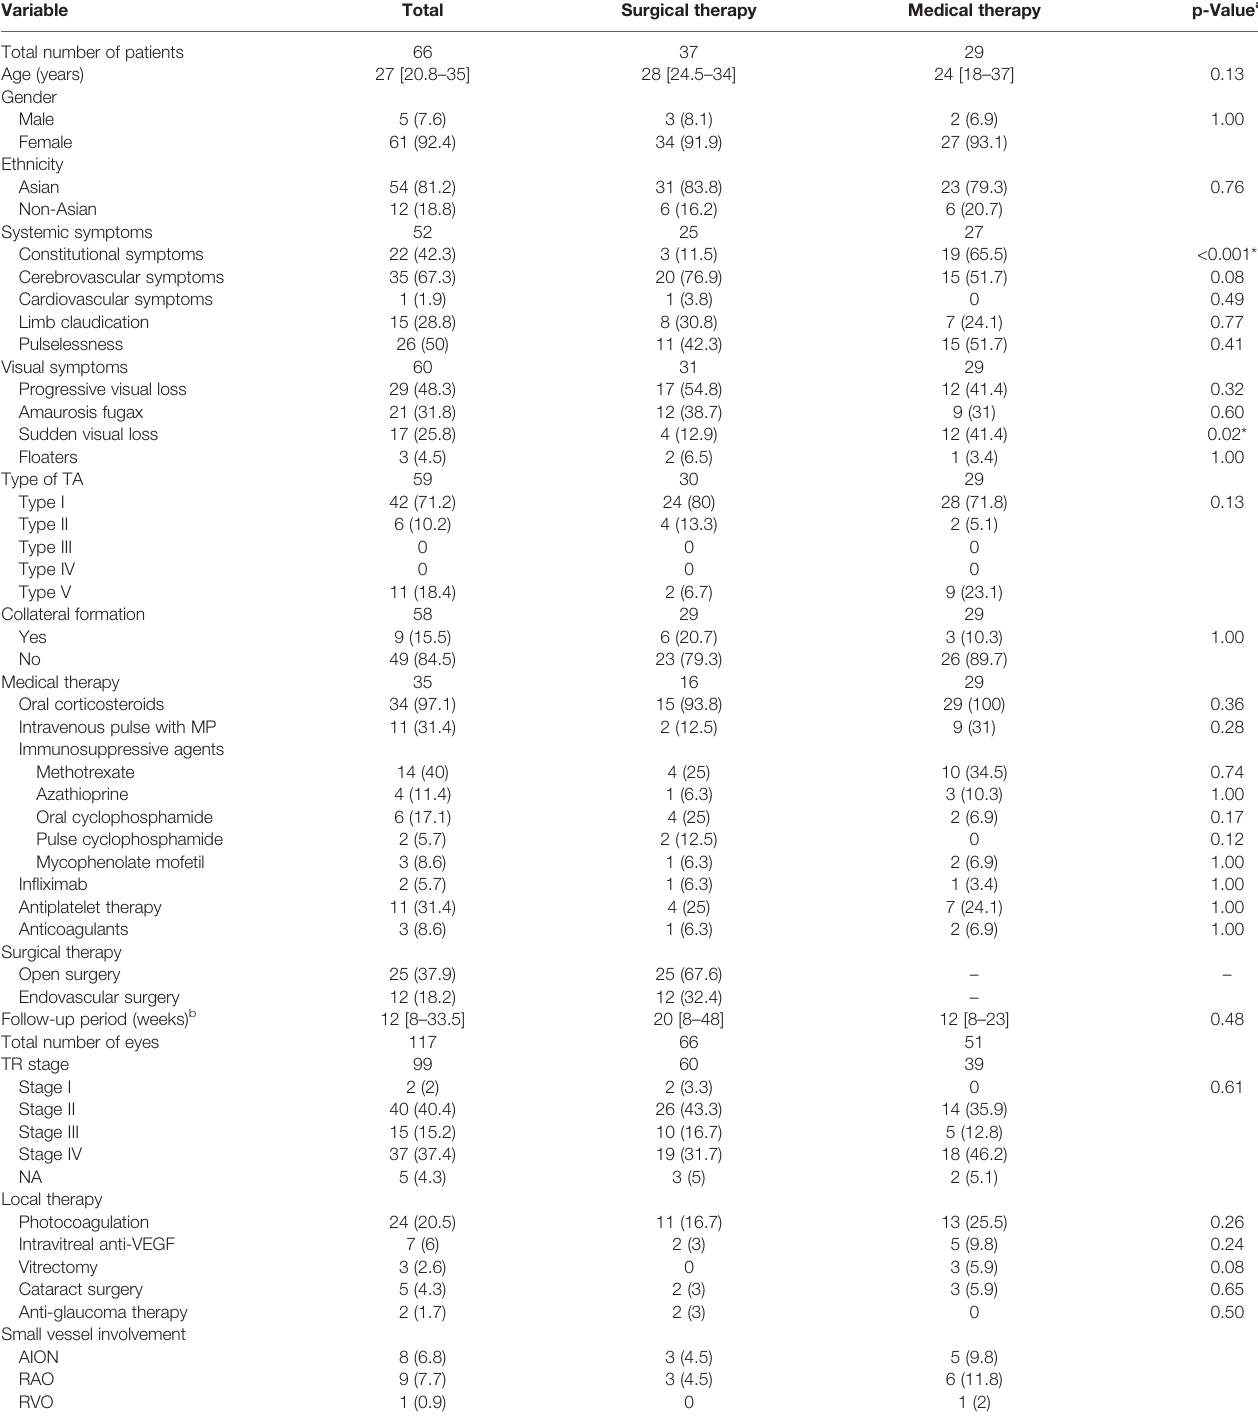
TABLE 1 | Summary of clinical characteristics of 66 cases (117